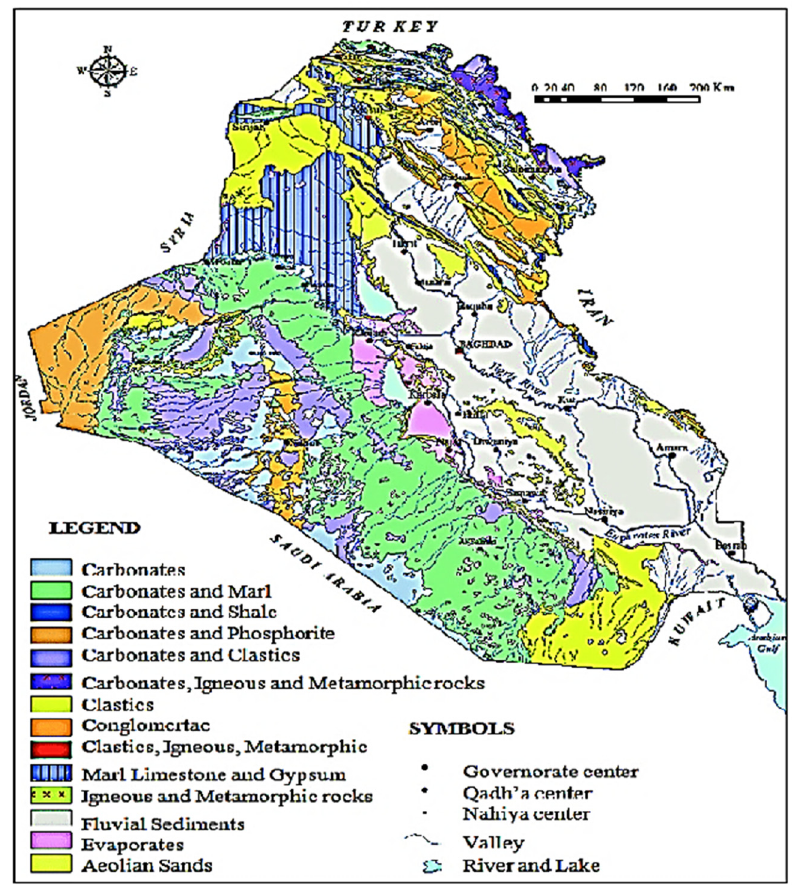
Figure 3: Geological